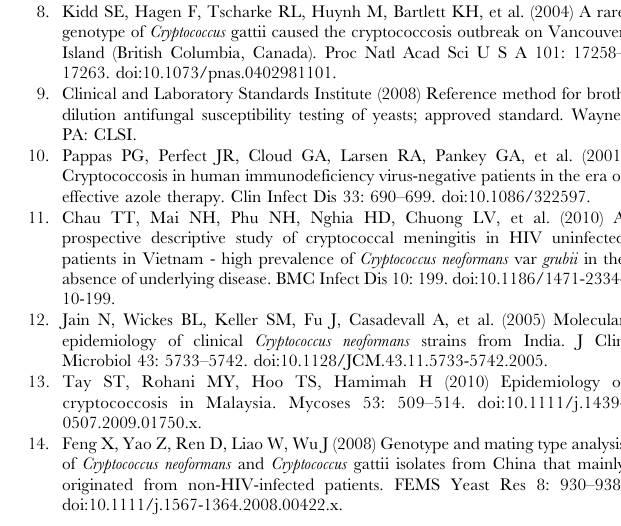
Table S1 Microbiological, epidemiological, and clinical charac- teristics and outcomes of cryptococcosis due to VNII genotype in Taiwan, 1997 to 2010. Table S2 Microbiological, epidemiological, and clinical charac- teristics and outcomes of Cryptococcus gattii in Taiwan, 1997 to 2010. Table S3 Microbiological, epidemiological, and clinical charac- teristics and outcomes of cryptococcosis due to Cryptococcus VNI isolates with antifungal minimum inhibition concentration above epidemiologic cutoff values in Taiwan, 1997 to